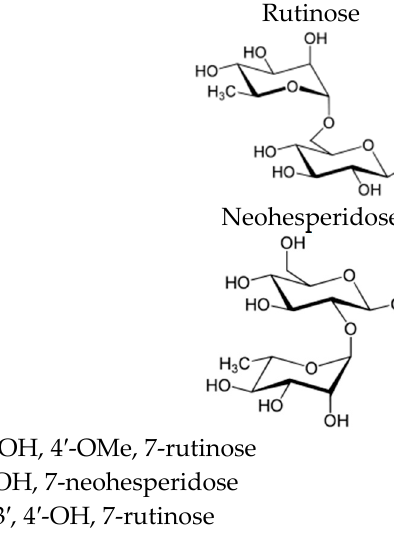
Figure 7. Chemical structures of the major bioactive flavones found in orange and lemon seeds.